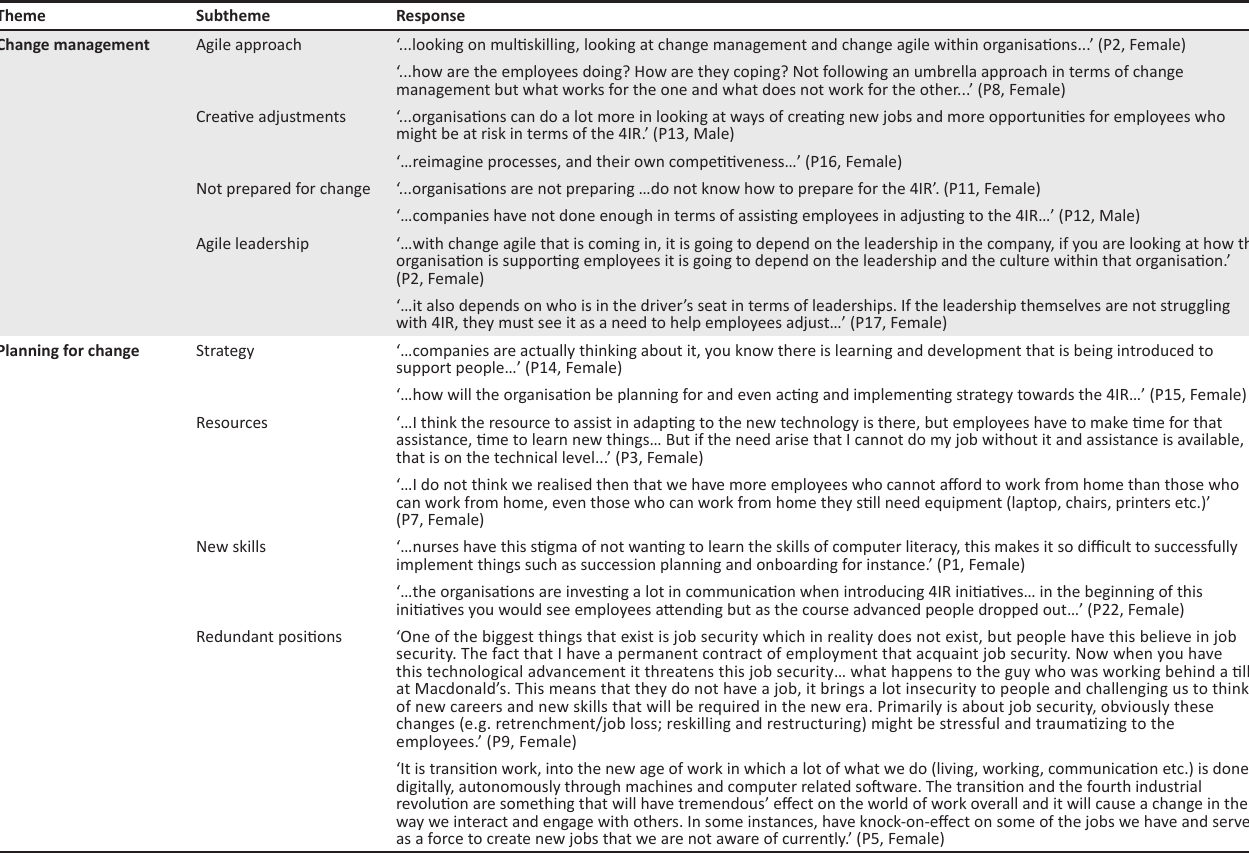
TABLE 1: Category 1: Experiences from the industrial psychology practitioners of the approach followed by the organisation in the changing world of